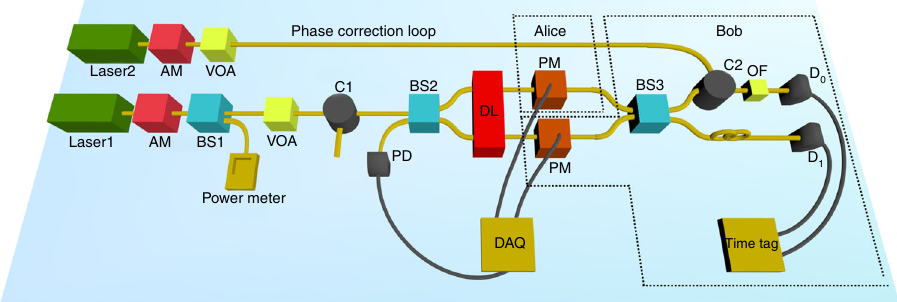
Fig. 5 Experimental setup for implementation of the quantum protocol for Sampling Matching with coherent states. A continuous wave laser operating at λ = 1563 nm (Laser1) followed by an amplitude modulator (AM) and an optical variable attenuator (VOA) is used for the generation of coherent light pulses at 1 MHz repetition rate and with 16 ns duration, at the mean photon number required for the protocol (see main text for details). The pulses are split at beam splitter BS2 to two paths corresponding to Alice and Bob. Alice encodes the phase information to her pulses sequentially according to her input string x ∈ {0, 1} n using a phase modulator (PM), while Bob prepares his sequence by encoding 0 to his pulses. Both modulators are controlled by a data acquisition card (DAQ). We use a delay line (DL) to adjust precisely the path lengths of the sequences such as to optimize their interference at the balanced beam splitter BS3. The output pulses are then directed to two single-photon detectors D 0 and D 1 , and the detection events are registered using a time tagger. To monitor and correct the phase drift in the pulse sequences of Alice and Bob, we use a phase-correction loop, which consists of a second continuous wave laser operating at λ = 1527 nm (Laser2), followed by amplitude modulation and attenuation, and a combination of circulators (C1, C2), an optical fi lter (OF) and a photodiode (PD), to suitably direct the monitoring pulses through the setup in the opposite direction than the signal while preventing this light from reaching unwanted devices. We also compensate for Alice ’ s and Bob ’ s path length difference induced by the presence of a different number of